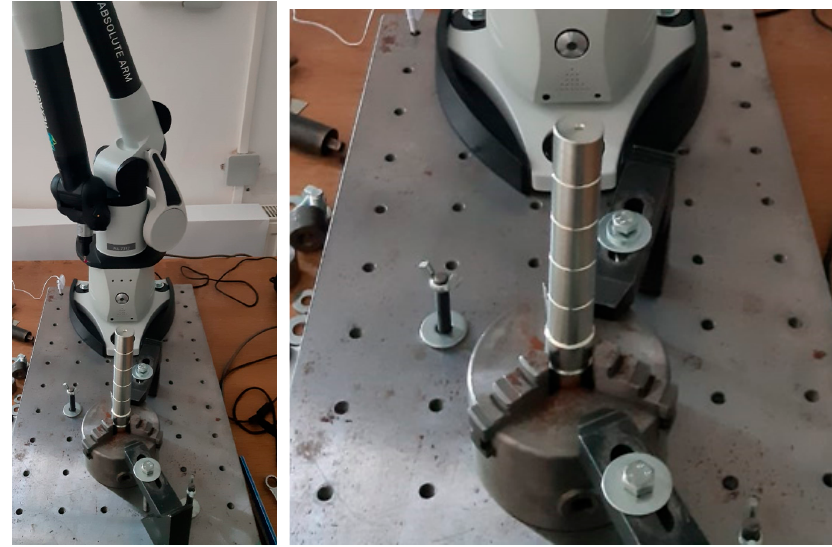
Figure 8. The technological assembly for measuring the parts.